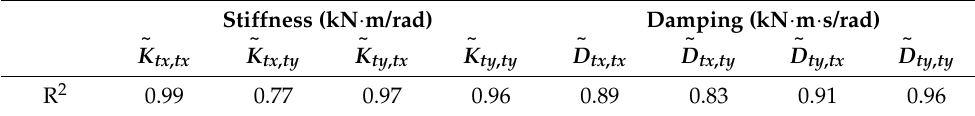
Table 2. Coefficients of determination for dimensionless dynamic coefficient fitting.